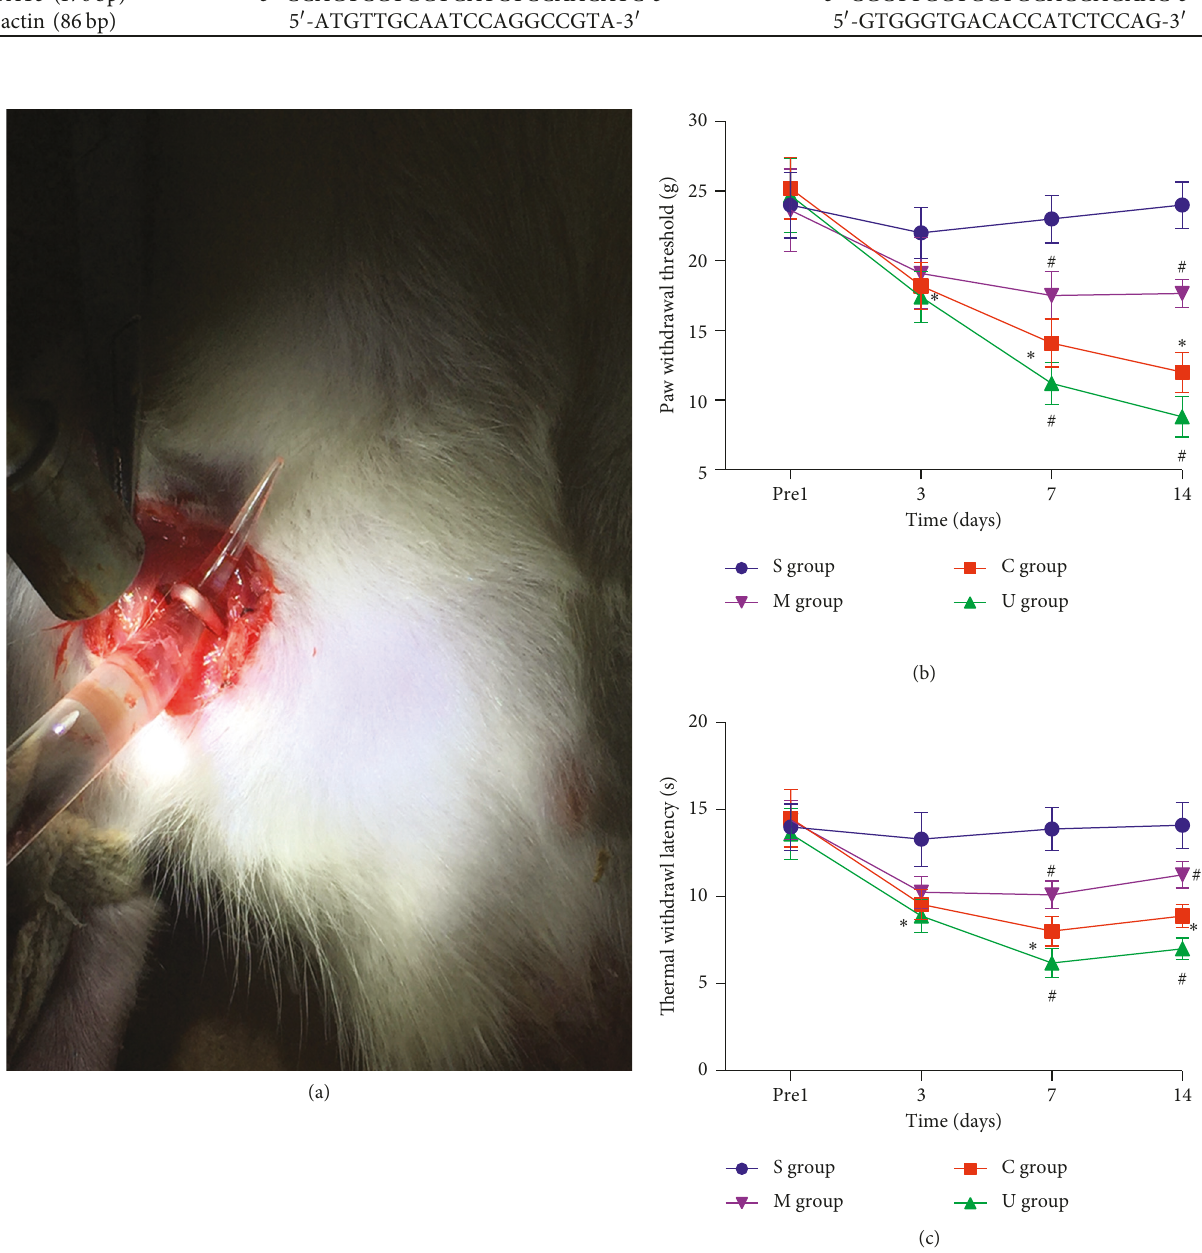
Figure 1: Manipulation of the P2Y6 receptor-modulated sense of pain in neuropathic pain (NP) in rat models induced by CCI. (a) The operation of CCI surgery. Changes of PWT (b) and TWL (c). Data (mean ± SEM) were presented in all rats. S: sham-operated rats; M: CCI rats treated with MRS2578; C: CCI rats; U: CCI rats treated with UDP. Significance of pain behavioral changes was analyzed with two-way ANOVA followed by Holm–Sidak post hoc analysis ( ∗ P < 0 . 05, vs the sham group; # P < 0 . 05, vs the CCI group).